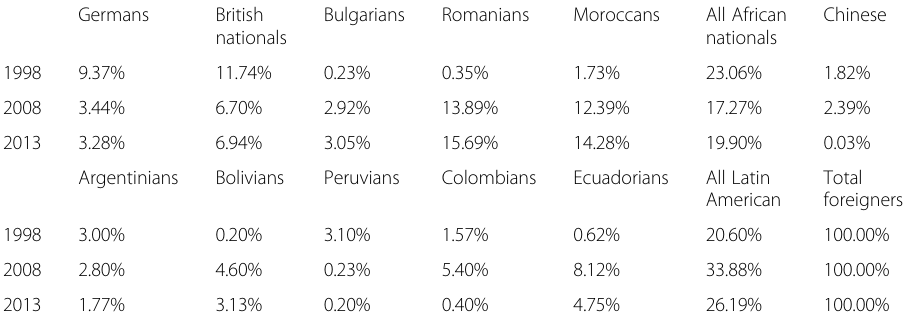
Table 4 Percentage of each group of foreign residents according to the total number of foreigners in Spain (source: Continuous Register,